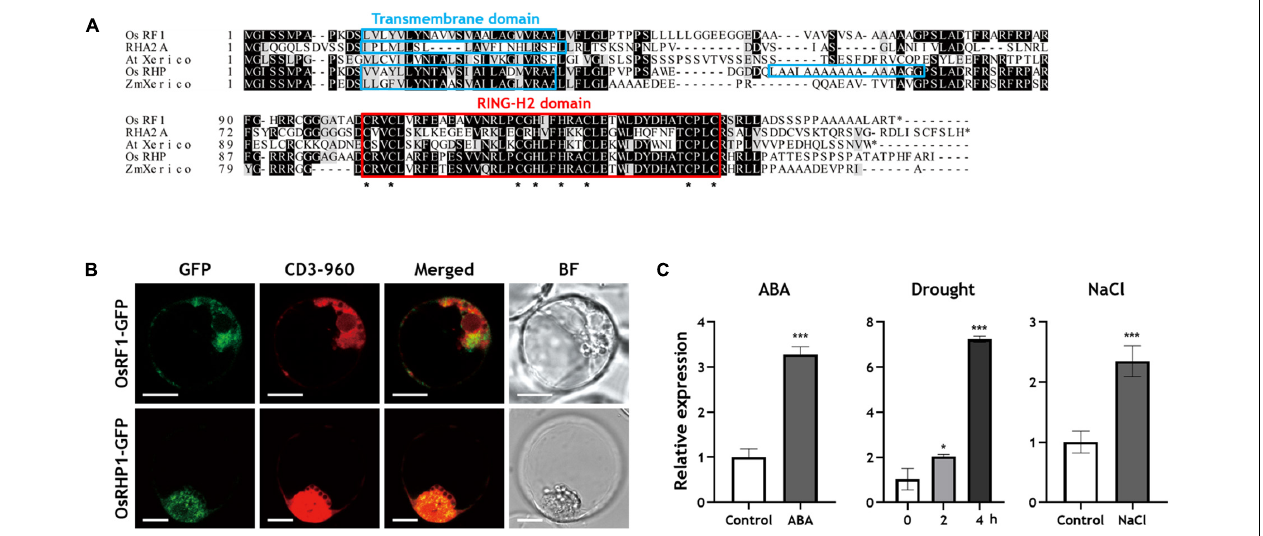
FIGURE 1 | Sequence alignment analysis, subcellular localization, and expression profiles of OsRF1. (A) Deduced amino acid sequence alignment of OsRF1 and other RING-H2 proteins. The predicted amino acid sequence of OsRF1 was aligned with Arabidopsis RING-H2 group A (RHA) 2A (NM_1013778), AtXerico (NP_178507), rice OsRHP1 (NP_001062121), and ZmXerico (NP_001151741) using Clustal Omega (https://www.ebi.ac.uk/Tools/msa/clustalo/). The red box and asterisks indicated RING-H2 domains and conserved Cys and His residues, respectively. Putative transmembrane domains were predicted using TMHMM2.0 (http://www.cbs.dtu.dk/services/TMHMM-2.0/) and indicated as light blue box. Identical (black boxes) and similar (gray boxes) sequences were also indicated. (B) Subcellular localization of OsRF1 and OsRHP1. The GFP-tagged OsRF1 and OsRHP1 were co-expressed with an ER mCherry marker, CD3-960, and visualized by confocal microscopy. The GFP and mCherry signals are represented in green and red, respectively. Bar = 10 µ m. (C) Expression of OsRF1 under various conditions. Ten-day-old seedlings were treated with 10 µ M ABA for 6 h, 200 mM NaCl for 6 h, and drought stress for 2 and 4 h. The relative expression level of OsRF1 in shoots was analyzed by qRT-PCR with the (cid:49)(cid:49) Ct method. The expression level of each gene was normalized with the expression level of the internal control gene, Ubiquitin 5 . Data represent mean ± standard deviation (SD) from three independent experiments with three biological replicates ( n = 3). Statistical analysis of data was performed by Student’s t -test. * P < 0.05, *** P < 0.005.